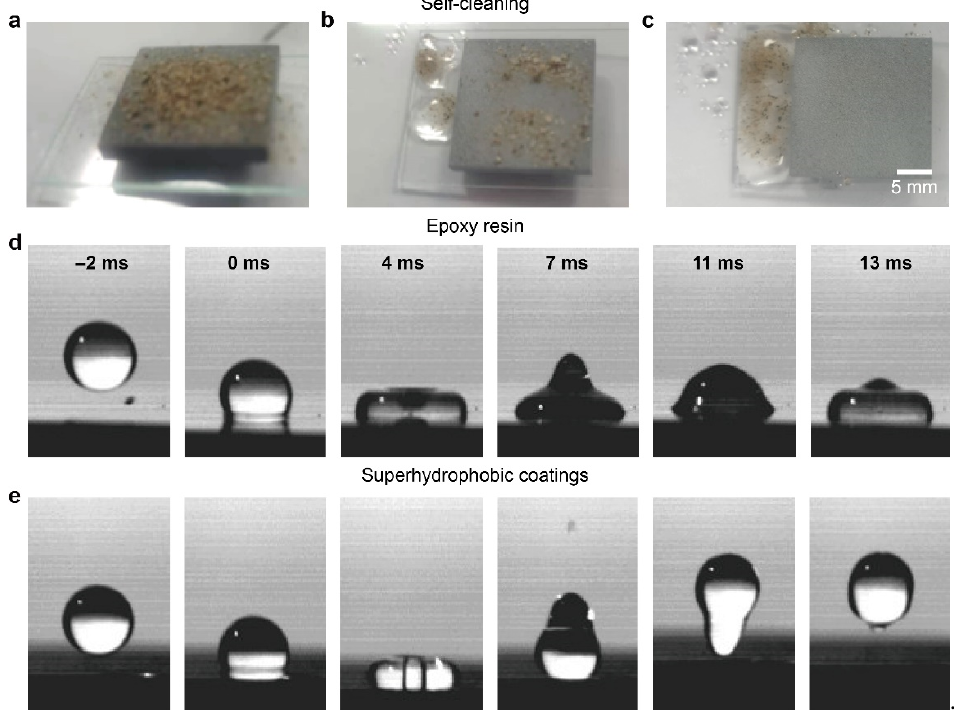
Figure 3. Self-cleaning of the F-SiO 2 /MXene superhydrophobic coating. ( a–c ) Digital image of the coatings depict the self-cleaning test process by dripping water on a dust-containing superhydrophobic surface. Droplet impact experiment on ( d ) the pure epoxy resin coating and ( e ) the F-SiO 2 /Mxene superhydrophobic coatings. Volume of the water droplet is 5 μ L.